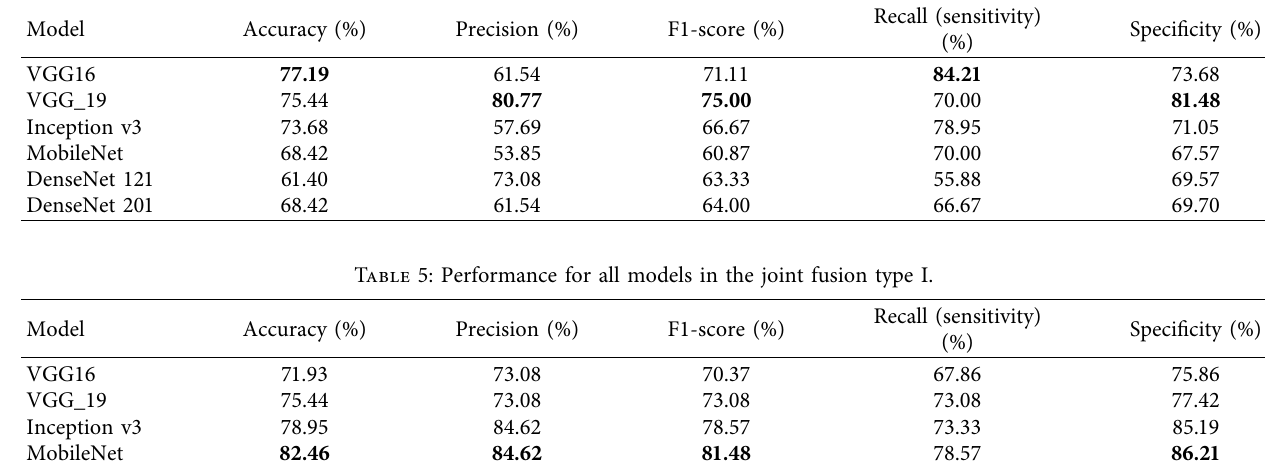
Table 4: Performance for all models in the joint fusion type II.